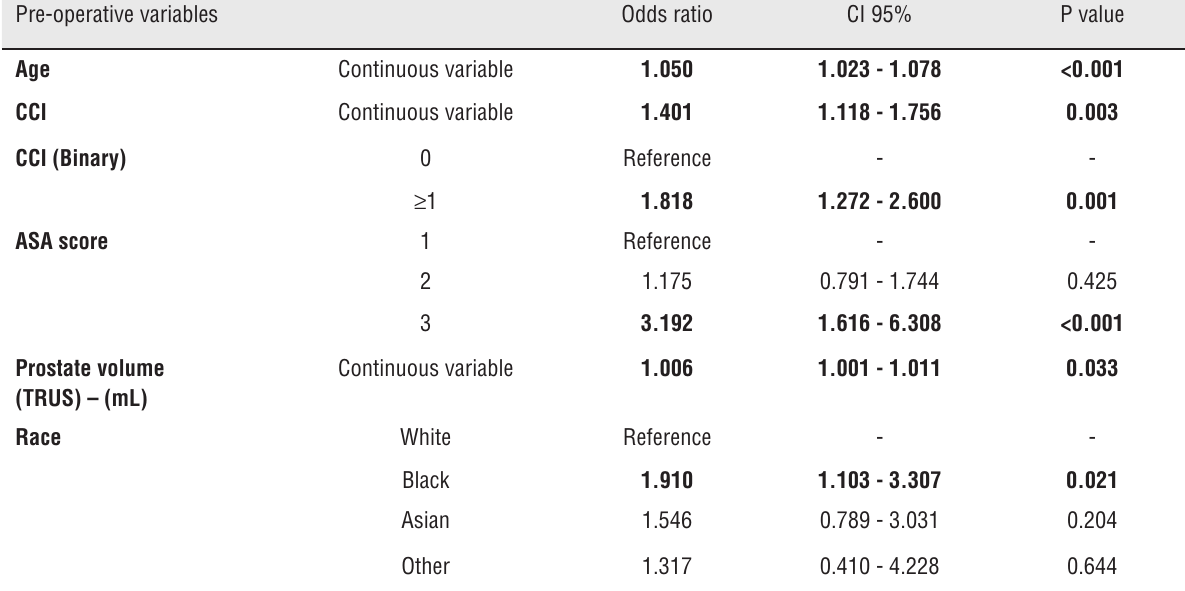
Table - 7A) Multivariate analysis – Predictors of prolonged hospitalization including solely pre-operative factors. Pre-operative